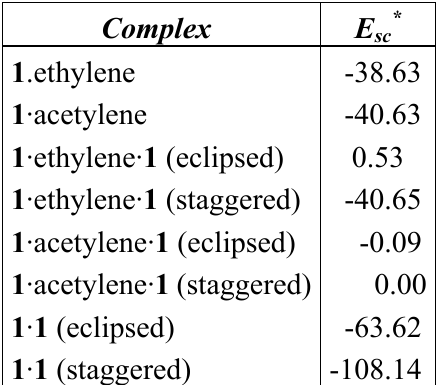
Table 5. Complex stability for different molecular complexes